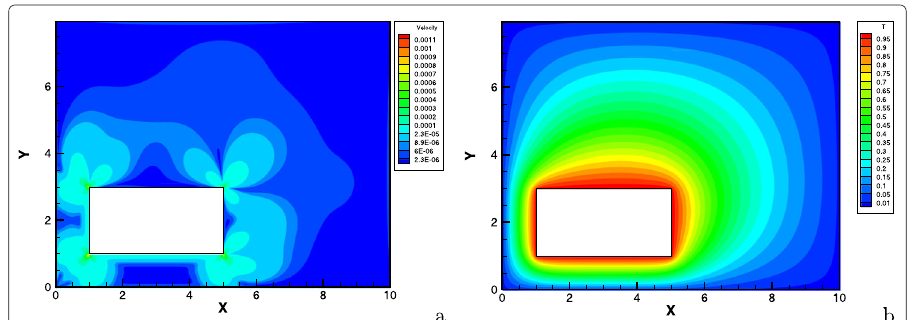
Fig. 15 The velocity magnitude (left) and temperature distribution (right) of the microbeam flow